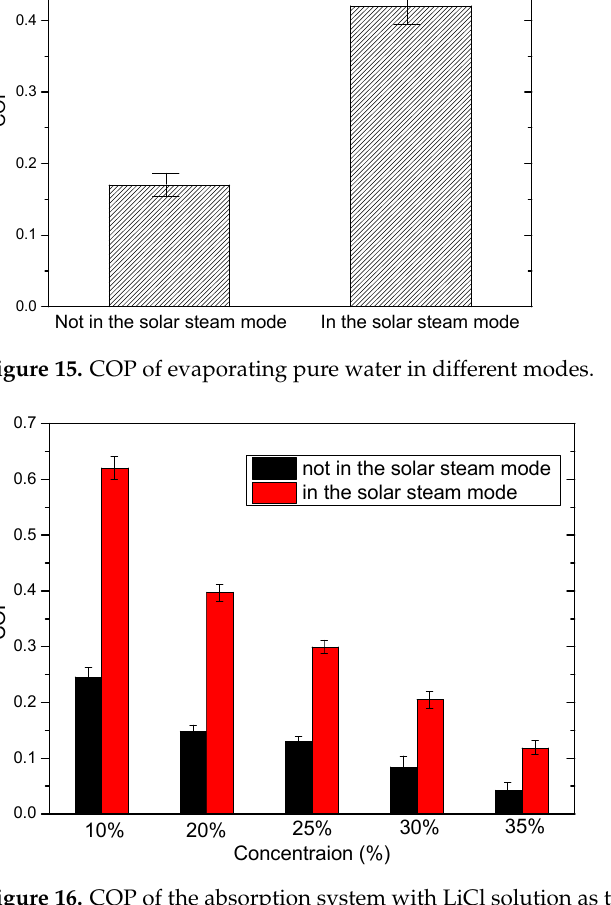
Figure 16. COP of the absorption system with LiCl solution as the absorbent in different modes.